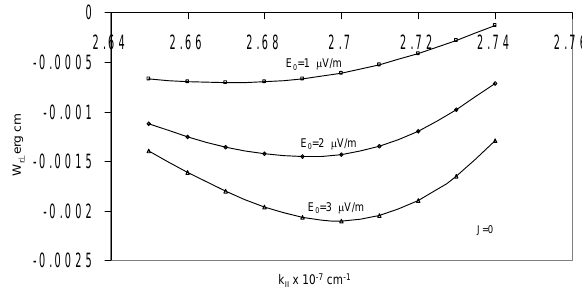
k II x 10 -7 cm -1